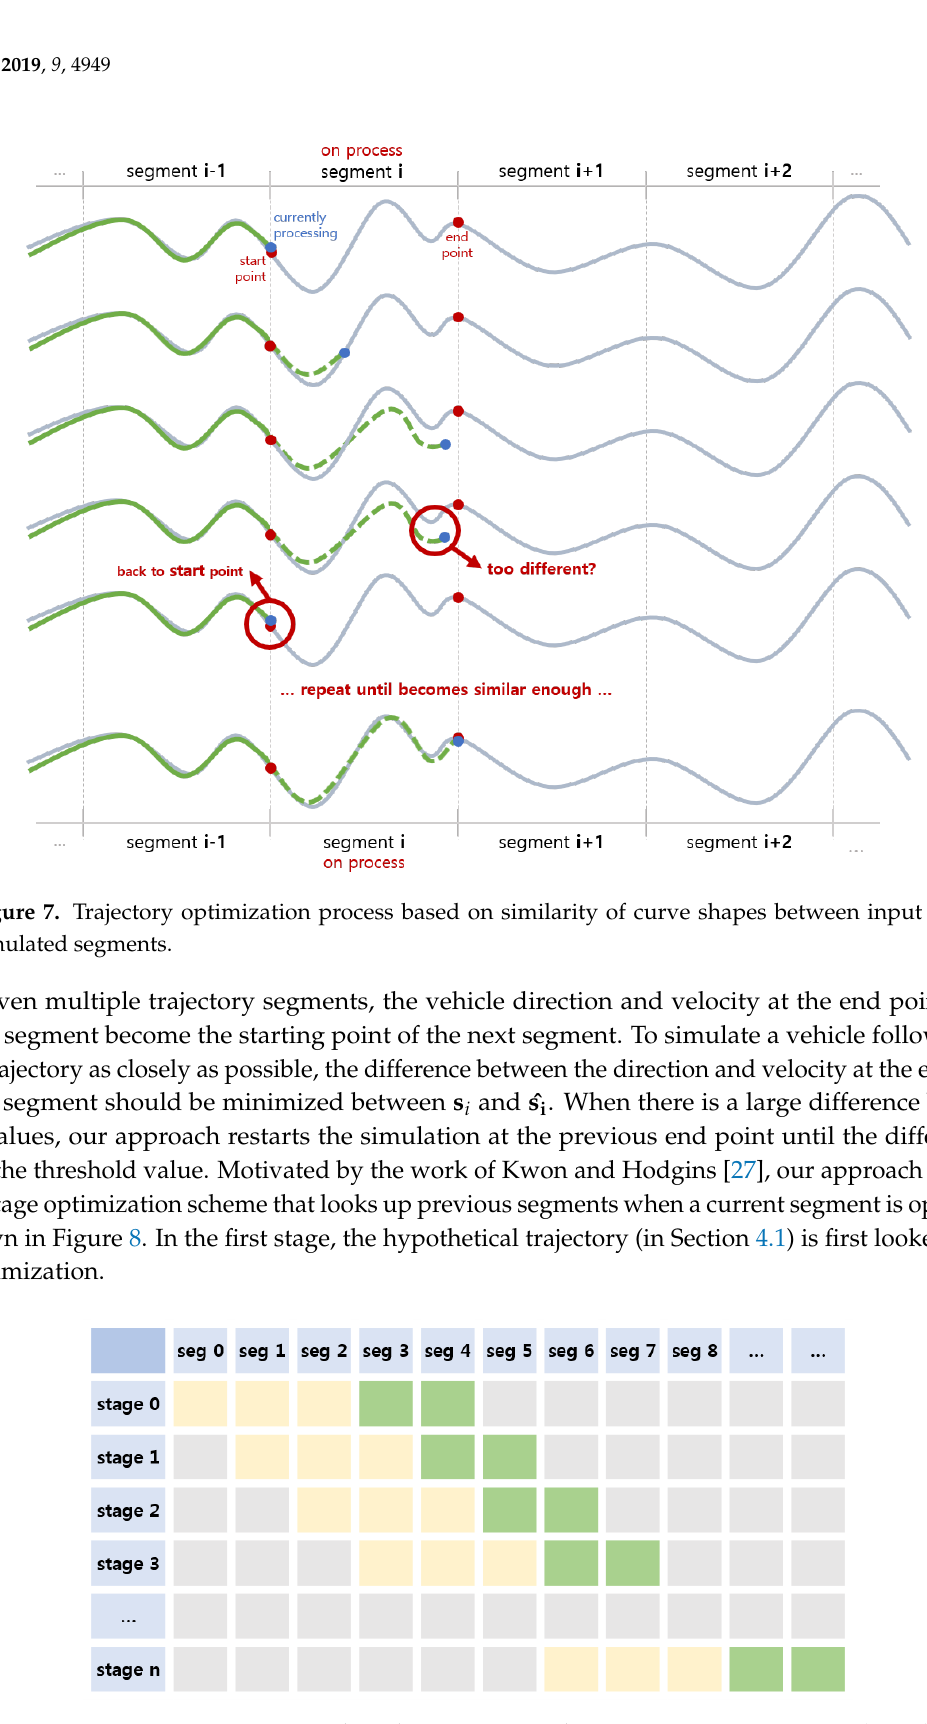
Figure 8. Trajectory optimization with multi-stages: At each iteration, current segments (green) are newly optimized based on previously optimized segments (yellow), where their shape can be modified depending on difference of vehicle conditions (direction and velocity) at the end points between the input and simulated